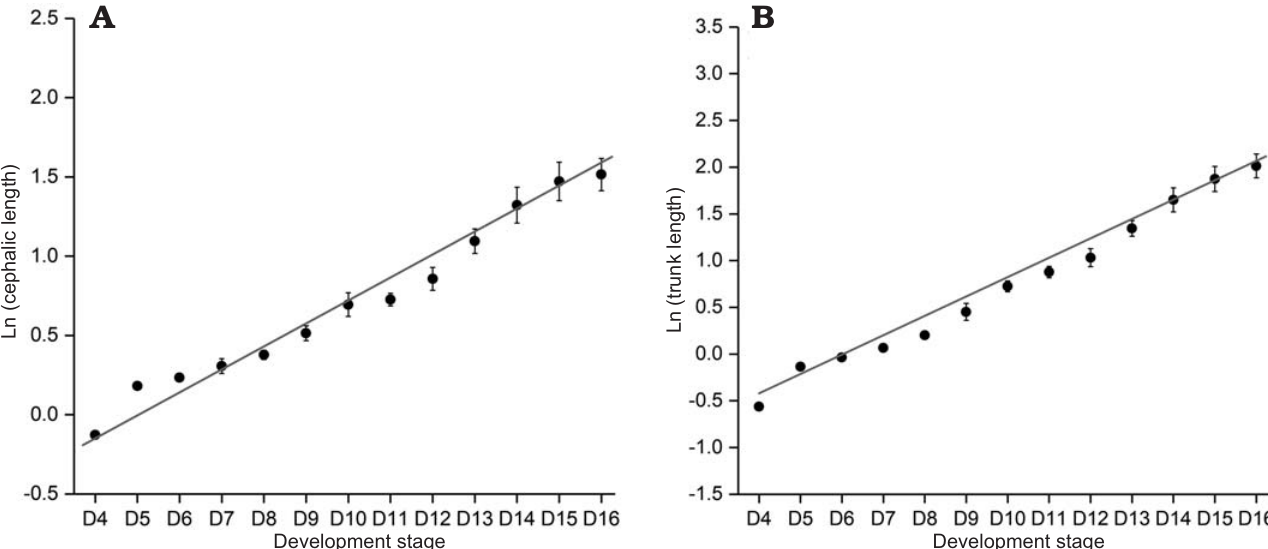
Fig. 11. Ontogenetic size progression from D4 to D16 of Changaspis elongata Lee in Chien, 1961. A . Least square linear regression of ln CEL d on the d stage (r A = 0.96622, n = 13). B . Least square linear regression of ln TRL d on the d stage (r B = 0.98373, n = 13). Bars are mean standard errors caused by